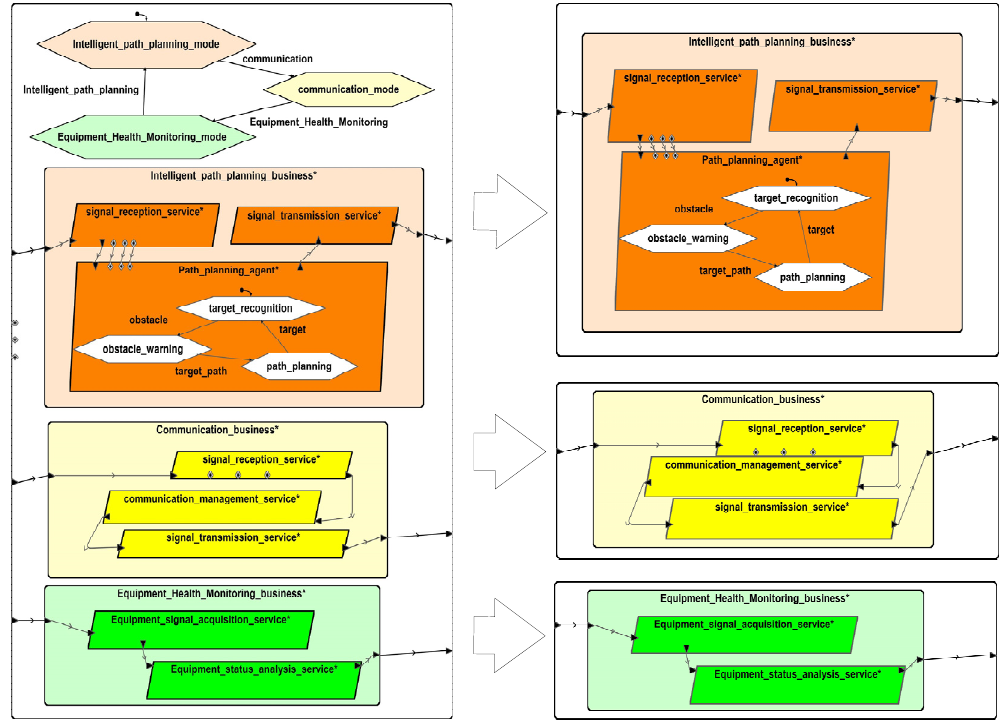
Figure 7. AADL model of SOA system with agents.